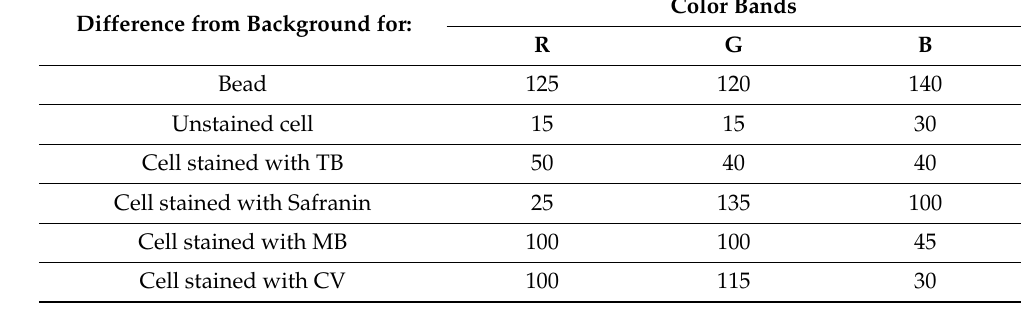
Table 1. Difference values from background for bead, unstained cell, and cells stained with basic stains. Difference from Background for: